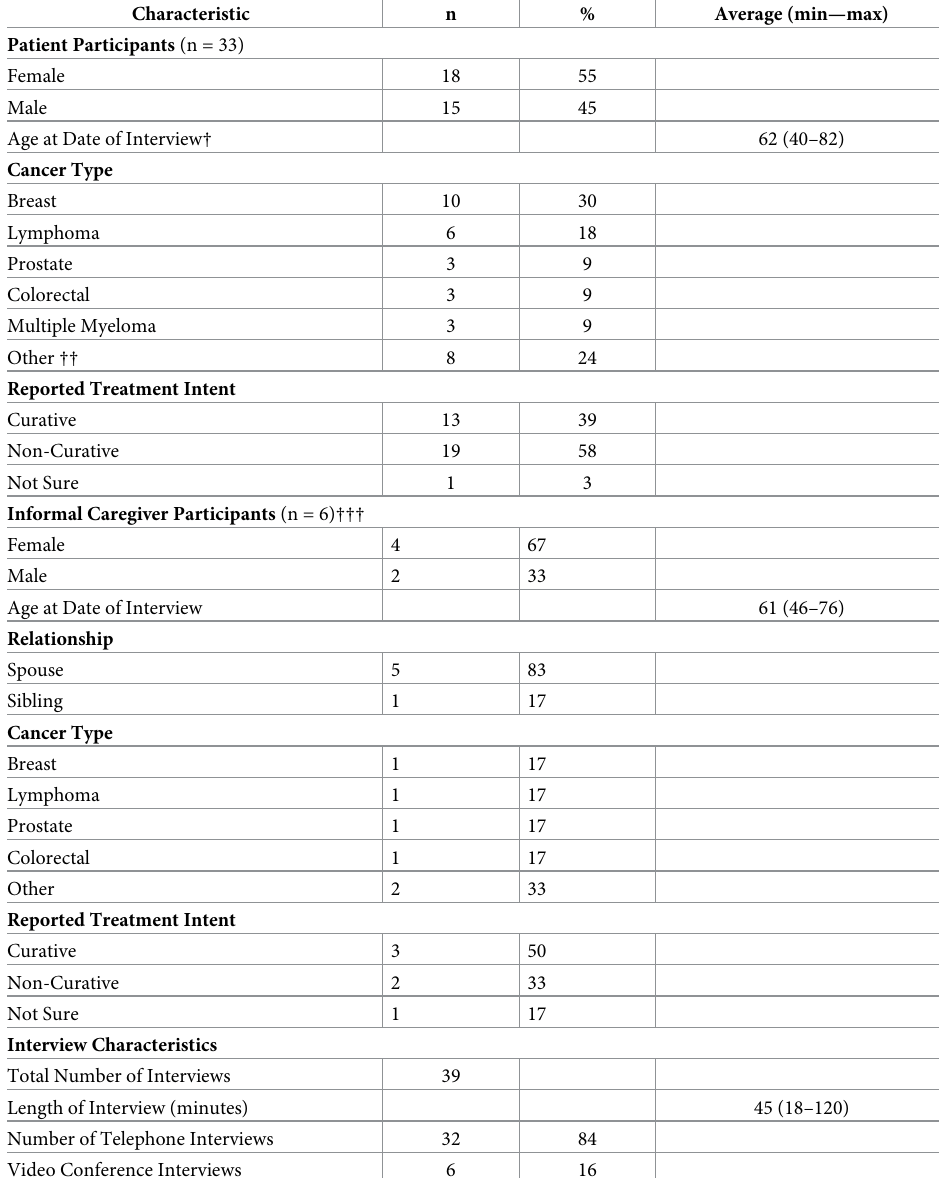
Table 3. Participant and interview